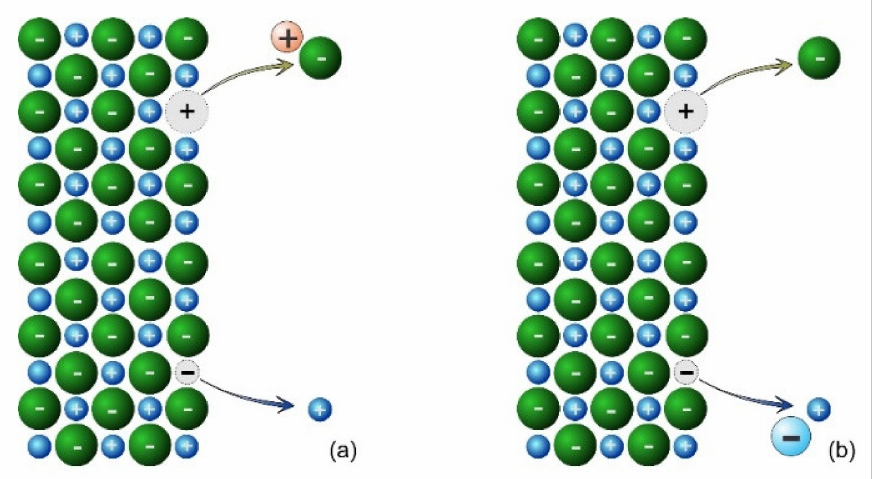
Figure 3. The underlying foundations of the physical models when ( a ) a hydronium ion interacts with the surface during dissolution in an acid environment, and ( b ) when a hydroxide ion interacts with the surface during the dissolution in an alkaline